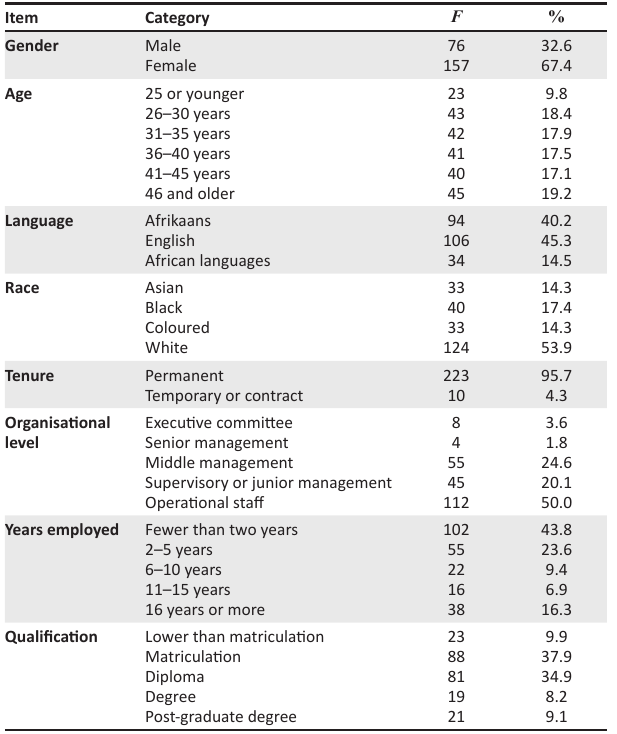
TABLE 1: Biographical details of